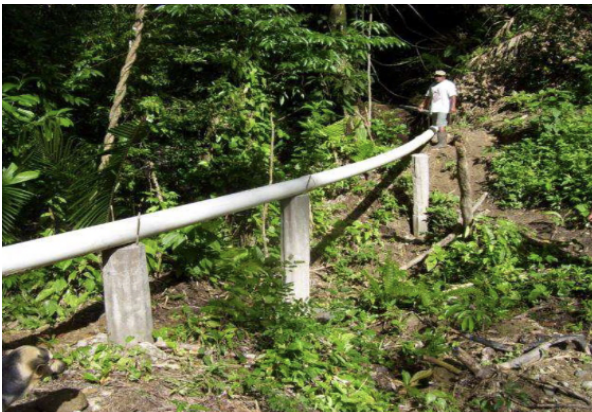
Figure 2. Bending in a real MHPP penstock